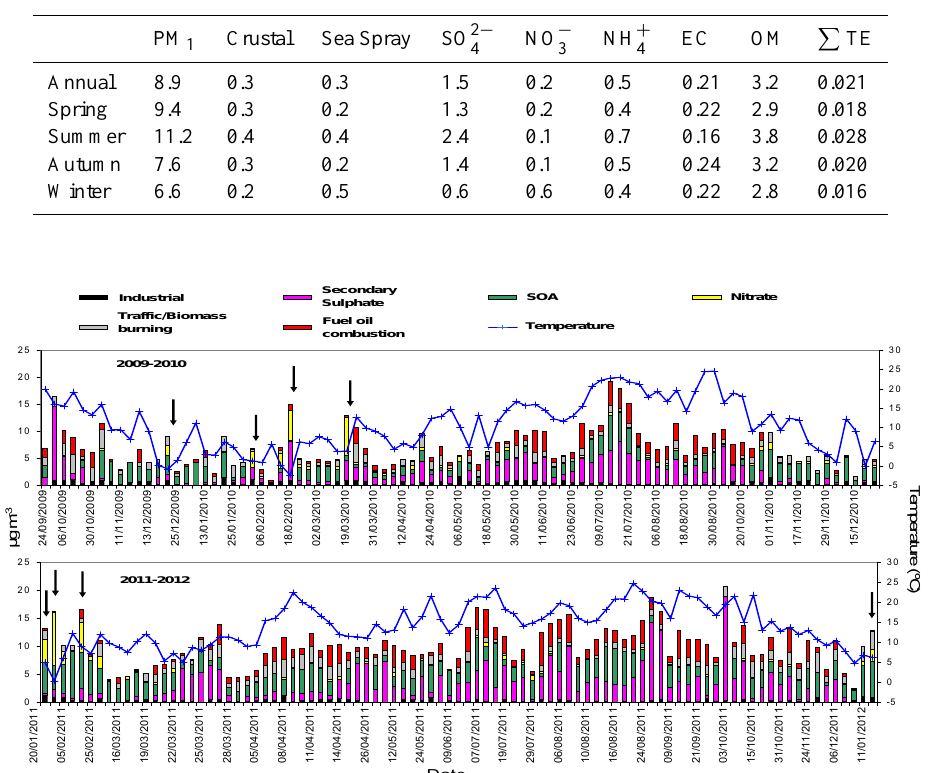
Table 1. Mean annual and seasonal concentrations for major components of PM 1 at MSY, and sum of concentrations of trace elements (TE), in µgm − 3 .